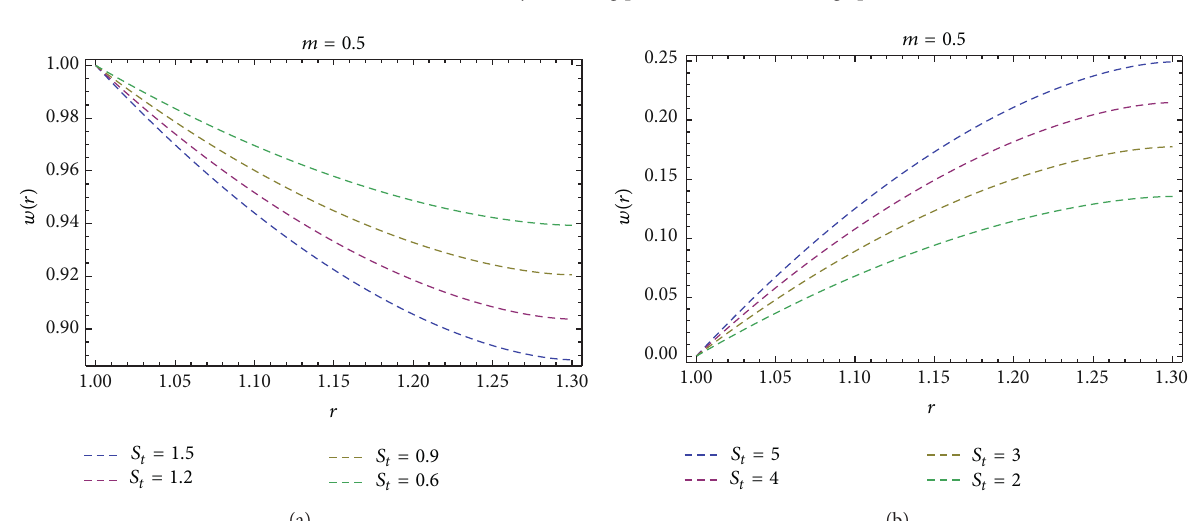
Figure 2: Effect of 𝑚 on velocity for lifting problem (a) and drainage problem (b).